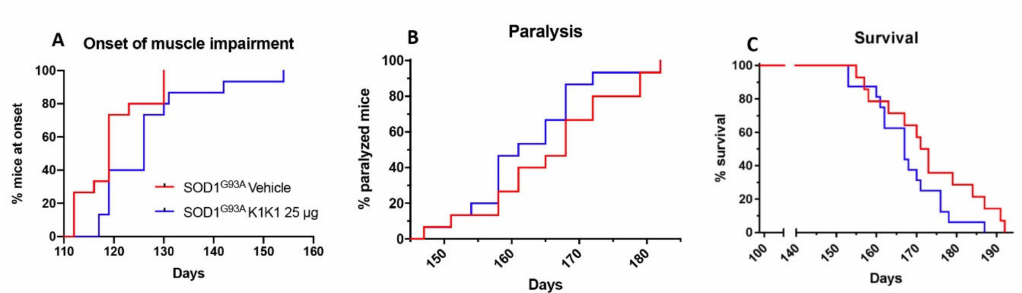
Figure 7. 25 µ g K1K1 delays neuromuscular impairment but not survival of SOD1G93A mice. ( A ) Kaplan–Meier curve showing, in a second group of mice, that treatment with 25 µ g K1K1 significantly delays the onset of motor symptoms ( p < 0.05, Log-rank test). ( B , C ) Kaplan–Meier curve showing that treatment with 25 µ g K1K1 did not a ff ect the age of paralysis ( p = 0.2956), considered as the age at which the mice were no longer able to perform the grip strength test, nor the survival length ( p = 0.1048) in SOD1G93A mice. The curves were evaluated using the Log-rank test ( n = 15 animals for each